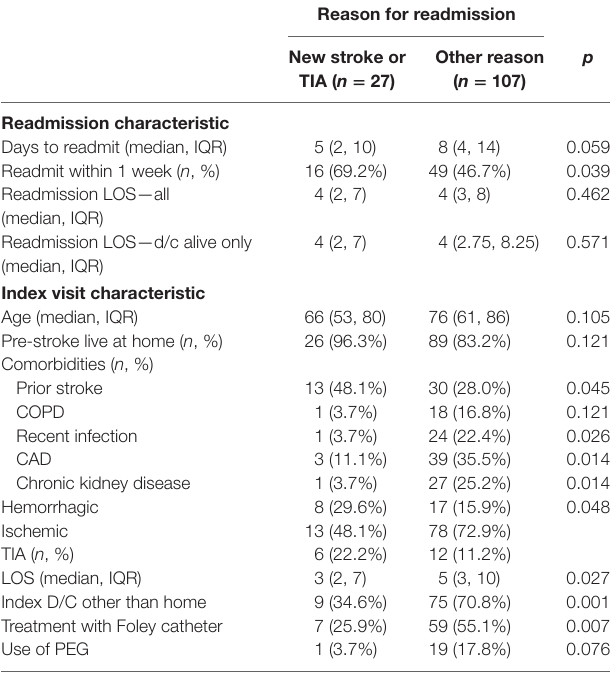
TaBle 2 | Readmission and index visit characteristics for new stroke event (stroke or TIA) vs. others.